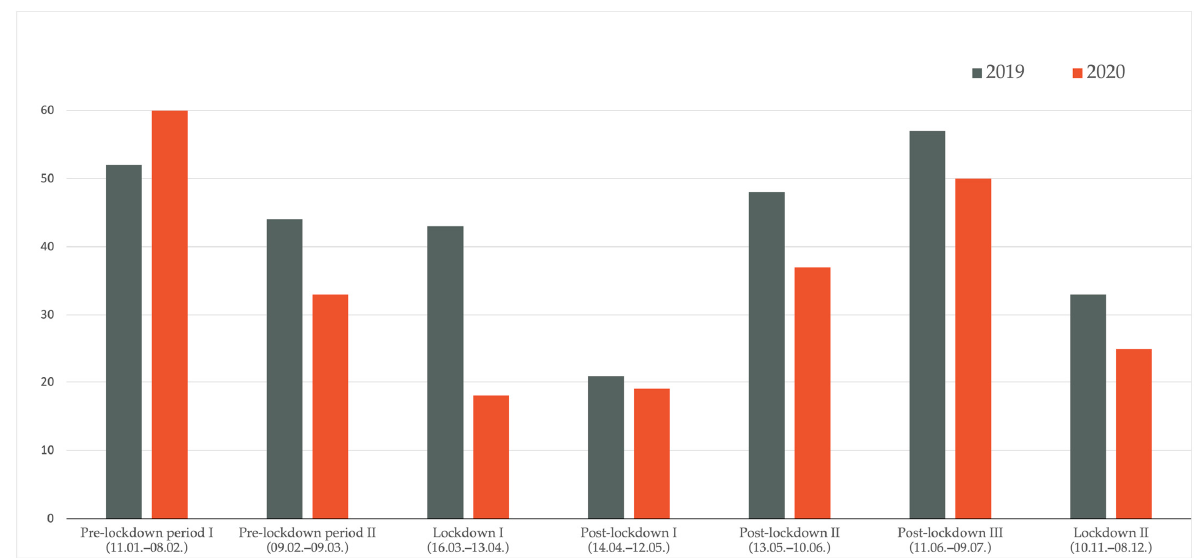
Figure 2. Comparison of melanoma cases 2019 versus 2020. Significant differences were detected in the lockdown period I (16 March–13 April).